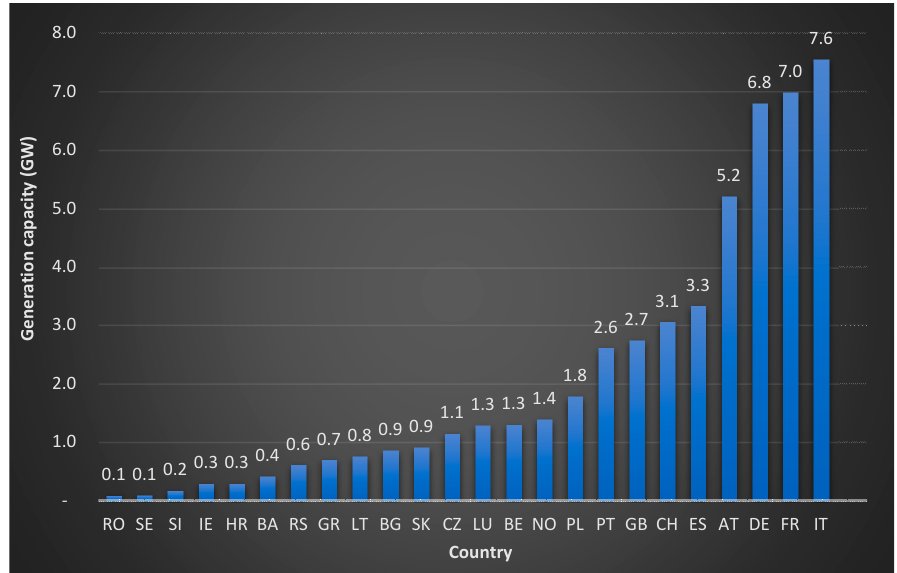
Figure 5. European installed pumped hydro storage (PHS) generation capacity in 2017 based on [45].